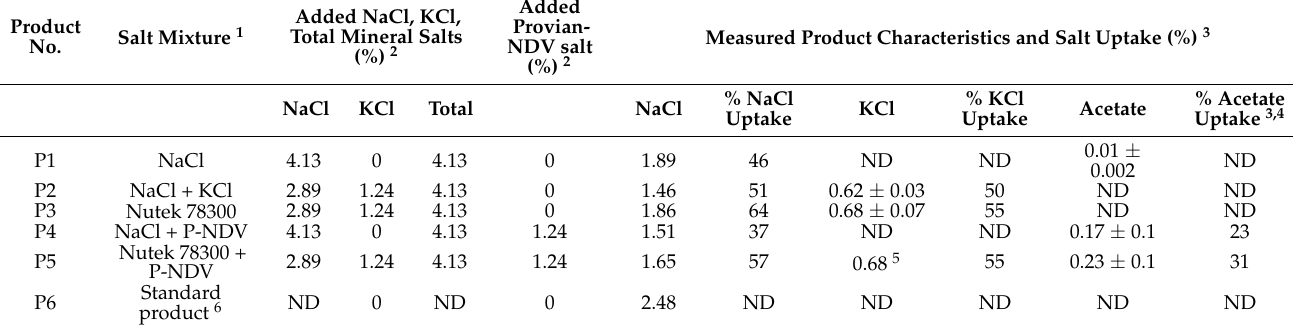
Table 2. Characteristics of industrially produced CS salmon.